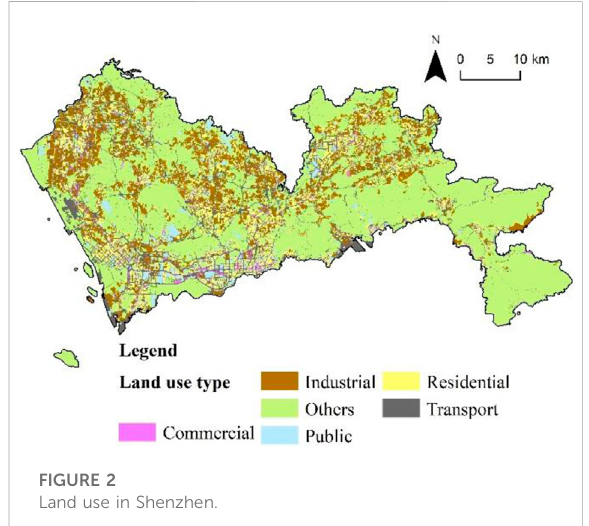
FIGURE 2 Land use in Shenzhen.